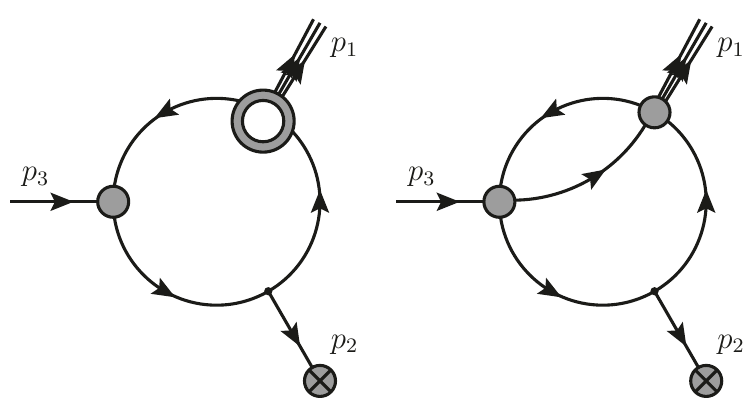
Figure 3 . Prototype two-loop Feynman diagrams with anomalous